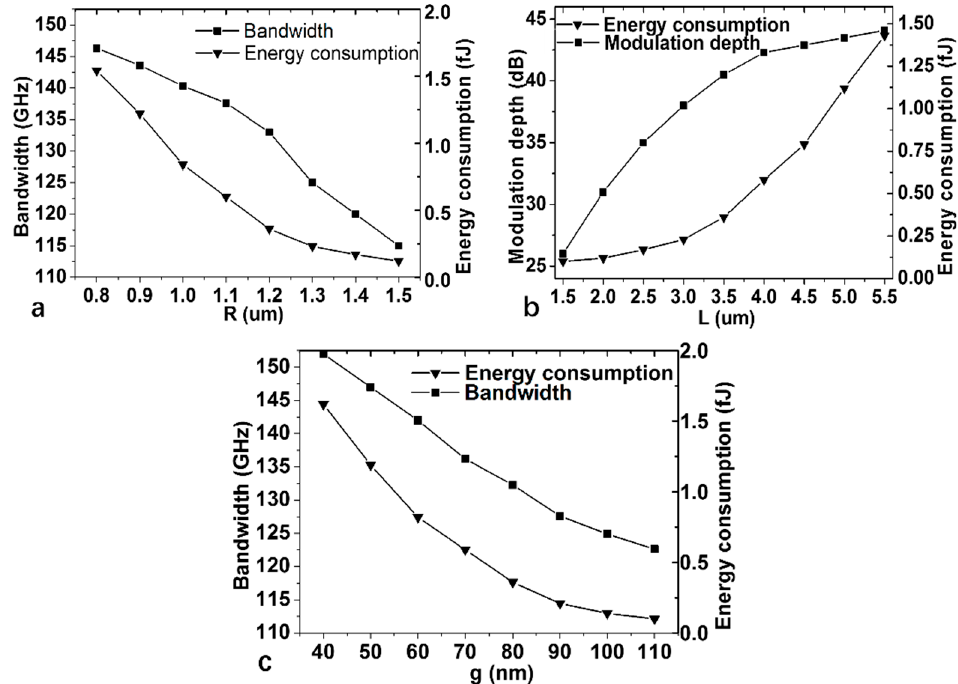
Figure 7. ( a ) The curve of the 3 dB bandwidth and energy consumption with the radius of the ring R. ( b ) The curve of the modulation depth and energy consumption with the average length L of the graphene. ( c ) The curve of the 3 dB bandwidth and energy consumption with the gap between the straight waveguide and the ring waveguide.